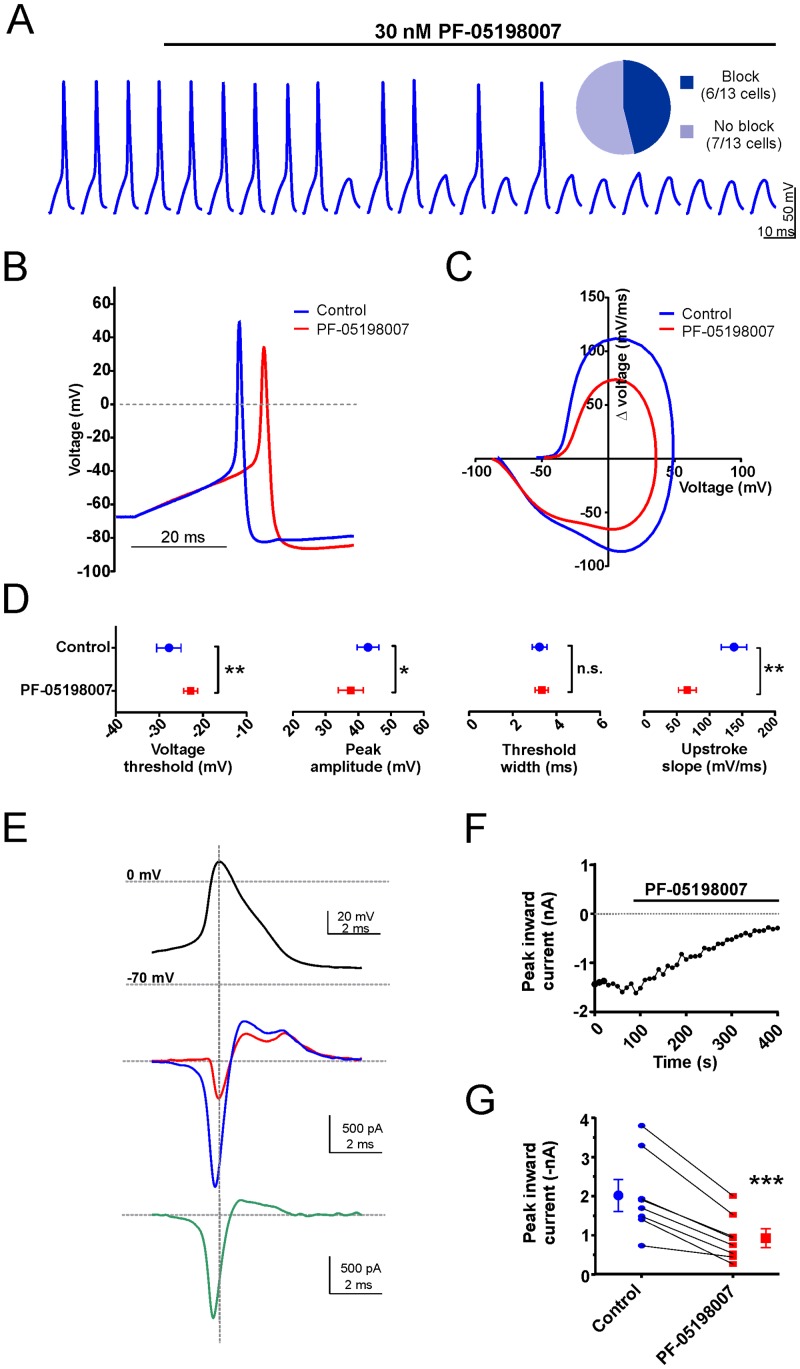
Nav1.7 controls action potential threshold and contributes to the rising phase.A. Example current clamp voltage traces in which PF-05198007 application resulted in action potential block. Single action potentials were evoked by a 20 ms suprathreshold current step at 0.1 Hz. The scale bar refers to the voltage traces whereas the start-to-start interval is 10 s. Inset: pie chart showing PF-05198007 (30 nM) resulted in complete action potential block in 6/13 neurons tested. B. Overlayed example action potential traces recorded from a neuron that exhibited partial block in response to PF-05198007 application. C. Phase plot of the action potential depicted in B. D. PF-05198007 depolarized the action potential voltage threshold and decreased both the peak amplitude and upstroke slope (n = 7 neurons, * p < 0.05, ** p < 0.01, paired t-test, data shown ±SEM). E. Example traces from an action potential voltage clamp experiment. Upper: the command action potential. Middle: overlayed current traces before (blue) and after PF-05198007 (30 nM, red). Lower: current subtraction revealing the current sensitive to block by PF-05198007. F. Example time-course of PF-05198007 effects on peak inward current. G. Scatter plot showing peak inward current for individual recordings as well as mathematical mean ± SEM before and after PF-05198007, n = 8 neurons, *** p < 0.001, paired t-test.